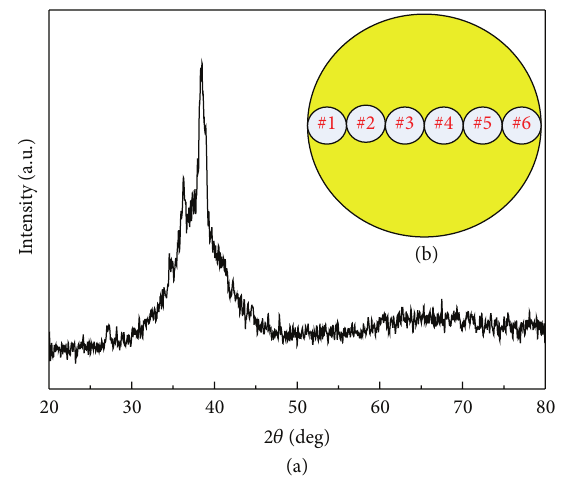
Figure 1: (a) XRD pattern of the as-cast Zr51 alloy with 12mm diameter, and (b) diagram of the alloy showing #1 ∼ #6 locations.